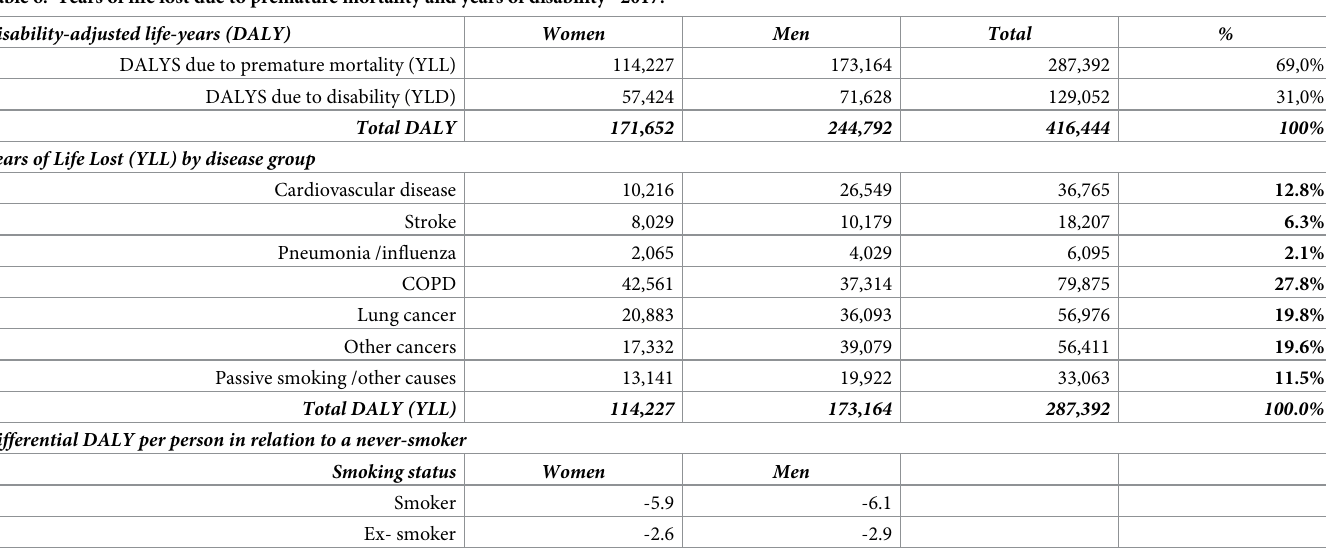
Table 6. Years of life lost due to premature mortality and years of disability– 2017. Disability-adjusted life-years (DALY) DALYS due to premature mortality